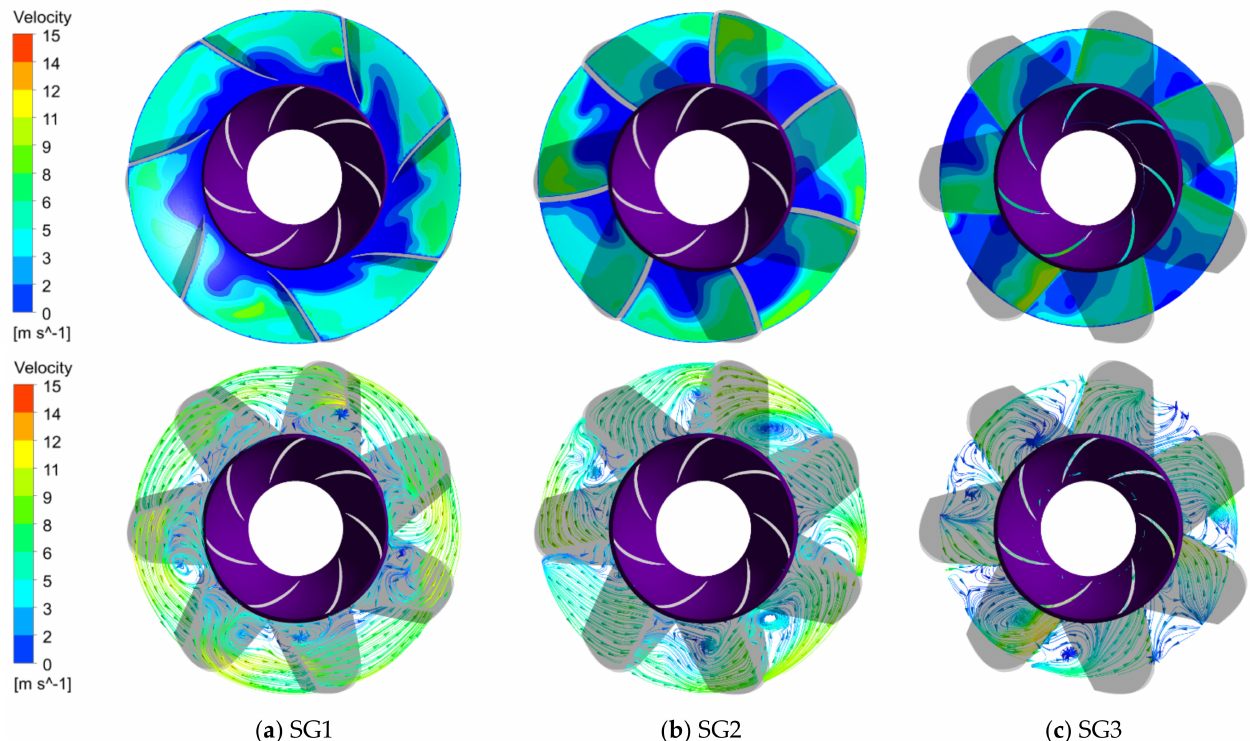
Figure 14. Flow axial velocity contours and streamlines within the diffuser under 0.83 Q BEP flow conditions for different positions along the streamwise